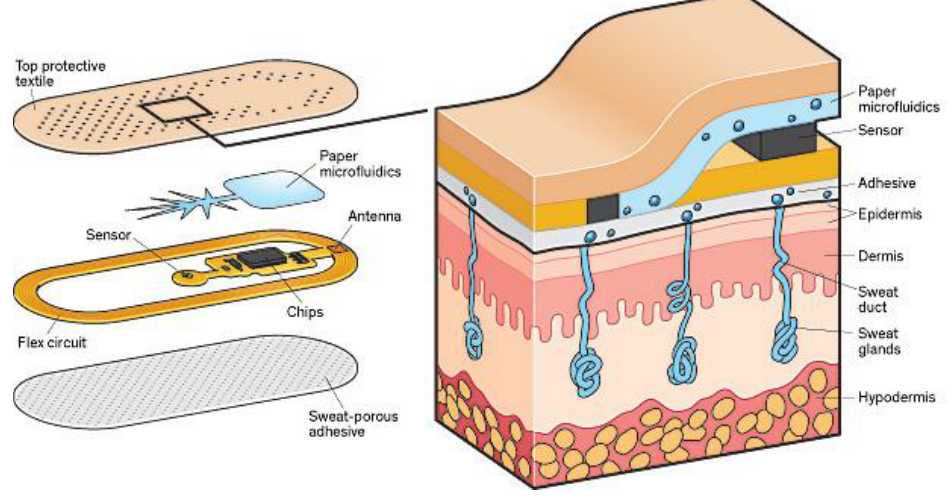
Figure 4. Patch developed at the University of Cincinnati using paper microfluidics to wick sweat from the skin through a selective membrane. Onboard circuitry calculates the ion concentration and sends the data to a smartphone. The electronics within the patch are externally powered, as in an RFID chip. Reprinted from [33].